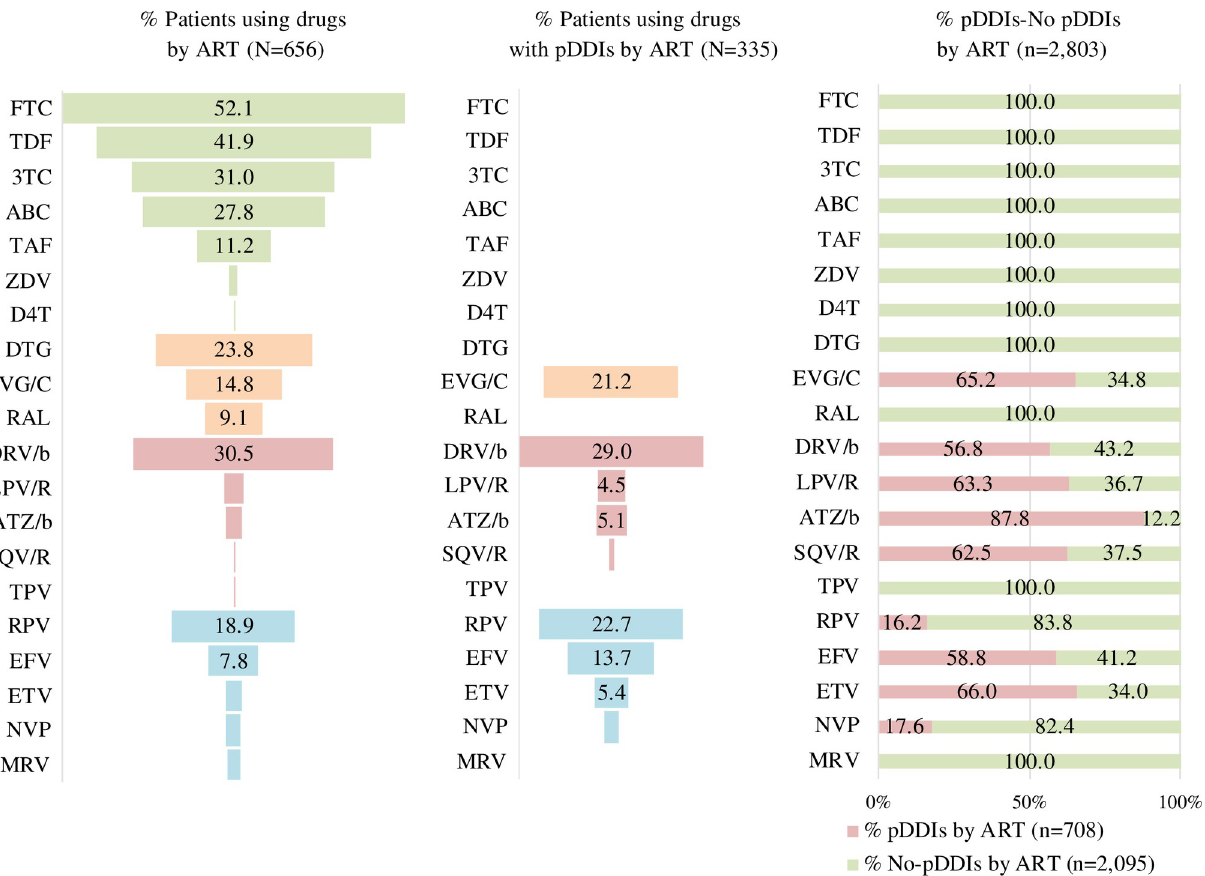
PLOS ONE | https://doi.org/10.1371/journal.pone.0260334 November19,